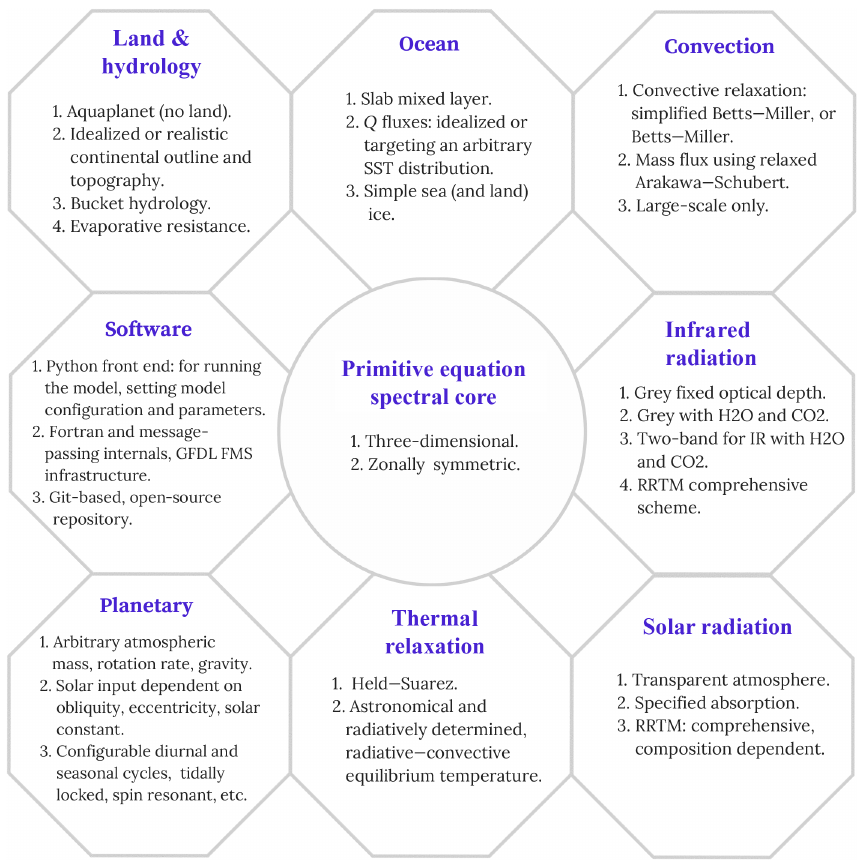
Figure 11. A summary of some of the main options currently available in